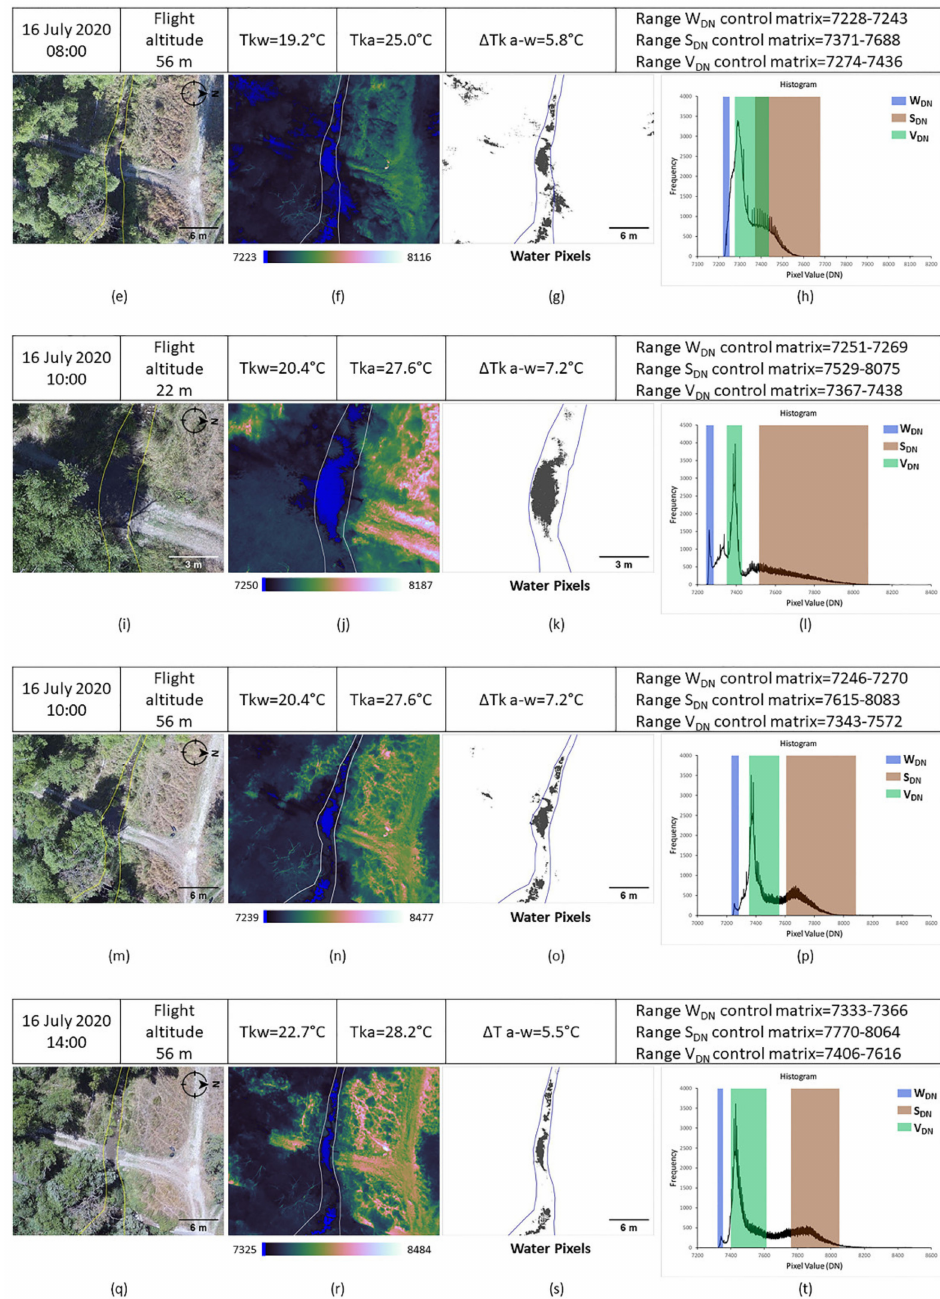
Figure 6. Surveys performed on 16 July 2020. At 07:00 ( a – d ), 08:00 ( e – h ), 10:00, 22 m ( i – l ), 56 m flight altitude ( m – p ), and 14:00 ( q – t ). For each row, the following images are shown: RGB image, with the delimitation of the geomorphic channel ( a , e , i , m , q ); the corresponding IR thermal image in false color, with the delimitation of the geomorphic channel ( b , f , j , n , r ); the pixels within the W DN range ( c , g , k , o , s ); the frequency distributions of the DN values of the thermal images, with three bands highlighting the W DN , S DN, and V DN ranges ( d , h , lp , t ). Furthermore, information is provided about the date, time, and height of the flight; Tka, Tkw and ∆ Tk a–w; and minimum and maximum values of W DN , S DN, and V DN